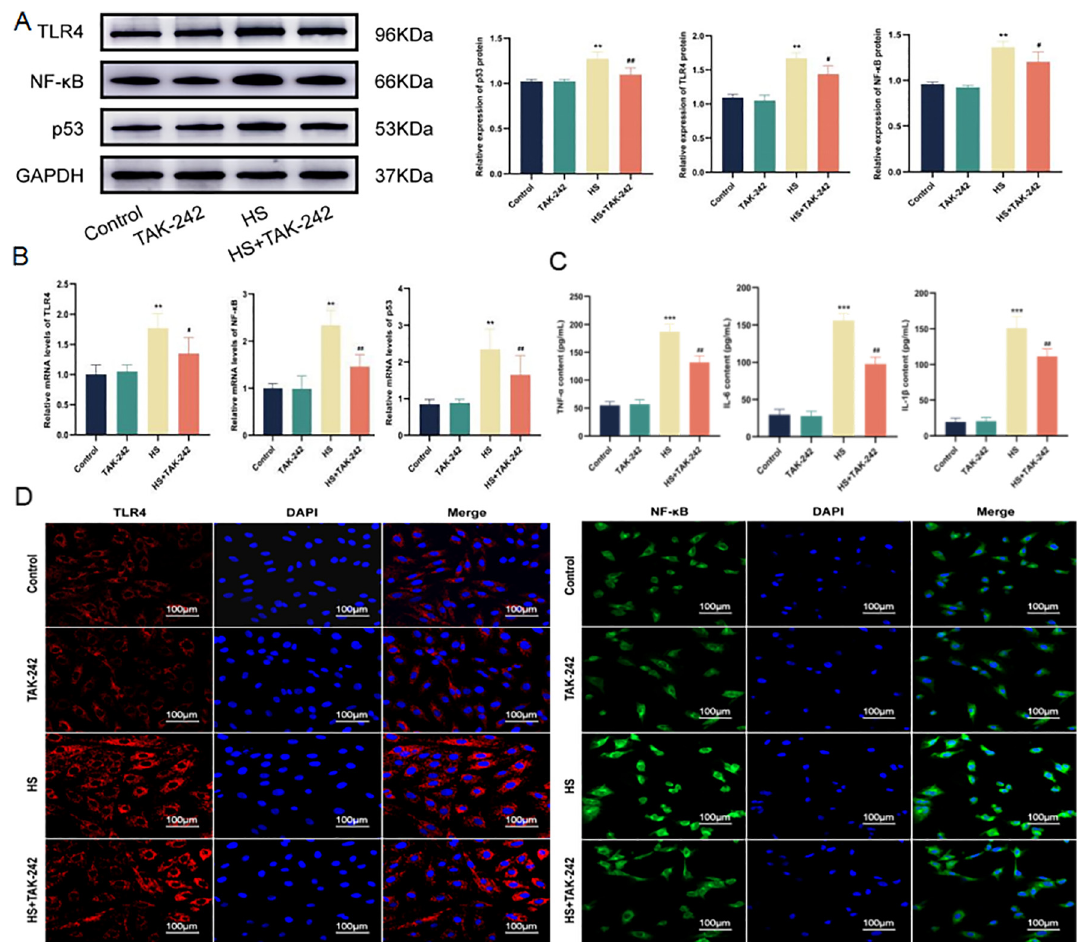
Figure 5. TAK-242 inhibits the HS-induced inflammatory environment. The protein levels of TLR4, NF- κ B, and p53 in H9C2 cells were determined using Western blotting ( A ). The mRNA levels of TLR4, NF- κ B, and p53 in H9C2 cells were determined using RT-qPCR ( B ). TNF- α , IL-6, and IL-1 β contents in H9C2 cells ( C ). Fluorescence images of H9C2 cells stained with DAPI, anti-TLR4 antibody, and anti-NF- κ B antibody. Scale bars = 100 µ m ( D ). The results were expressed as the mean ± SD deviation of three independent experiments, ** p < 0.01, *** p < 0.001 vs. the control group; # p < 0.05, ## p <0.01 vs. the HS group.